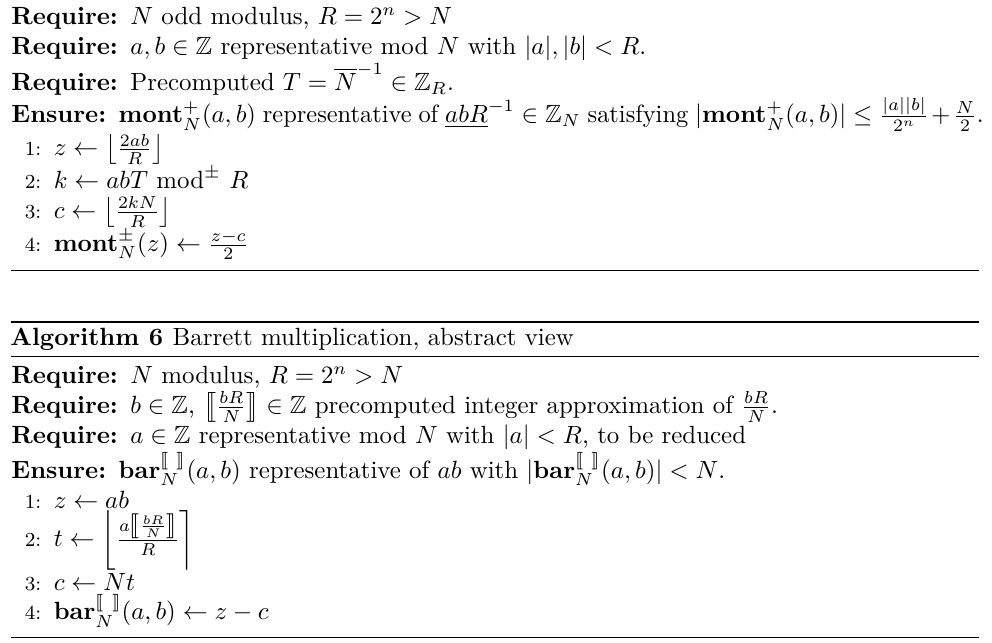
Algorithm 7 Montgomery multiplication via doubling, abstract view